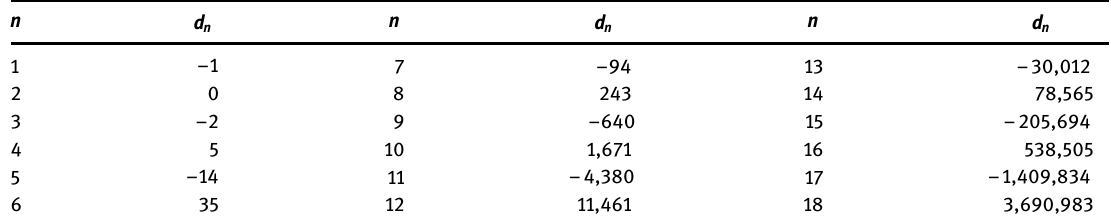
Table 2: The values of d n for 1 ≤ n ≤